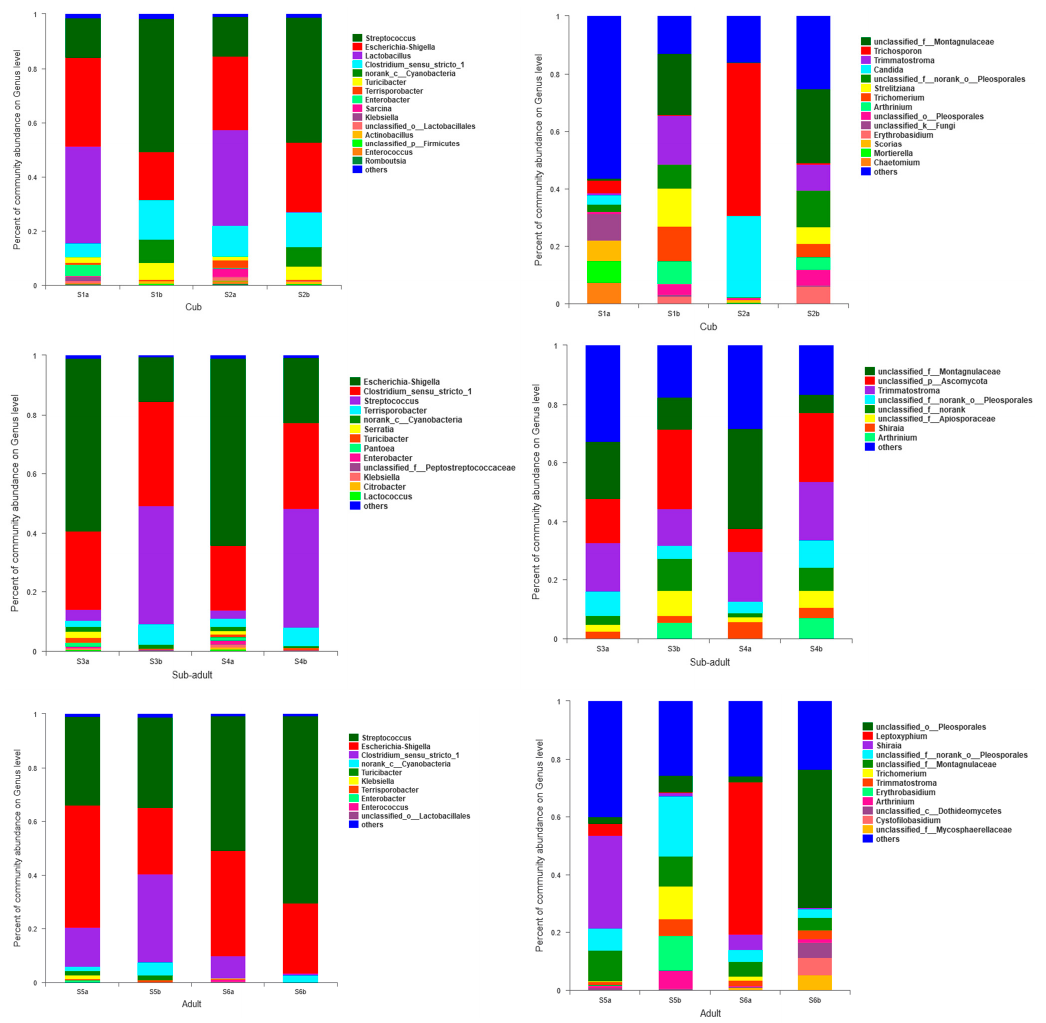
Figure 3. Bar diagram of intestinal dominant bacteria ( left ) and fungi ( right ) abundance in genera of different developmental stages for giant pandas. Others contain some microbes whose relative abundance is less than 0.05 in samples.